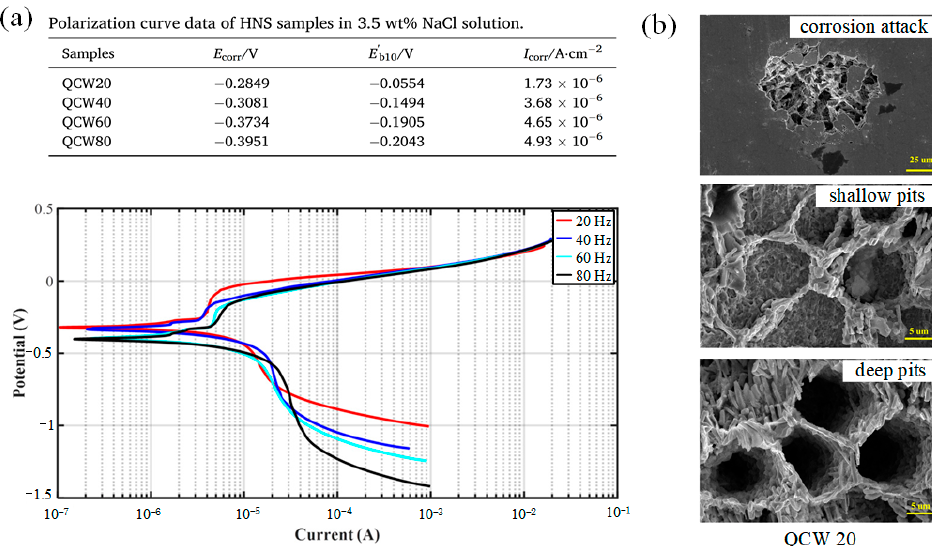
Figure 11. ( a ) Polarization curves of high-nitrogen steel (HNS) samples under various pulse fre- quencies, and ( b ) SEM images (2000 × ) of the QCW20 sample after the potentiodynamic polarization experiments. (Reprinted from ref. [27], copyright (2021), with permission from Elsevier).